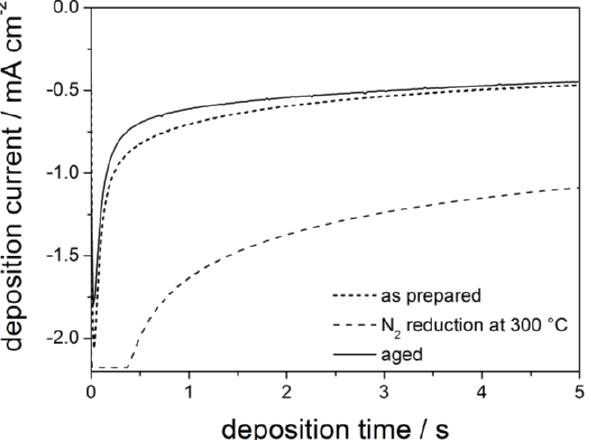
Figure 2. Current transients during electrodeposition of ZnO on as prepared (···), N reduced (- -) and aged (―) PIB-PEO 3000 templated ITO films at a deposition potential of −0.91 V vs.